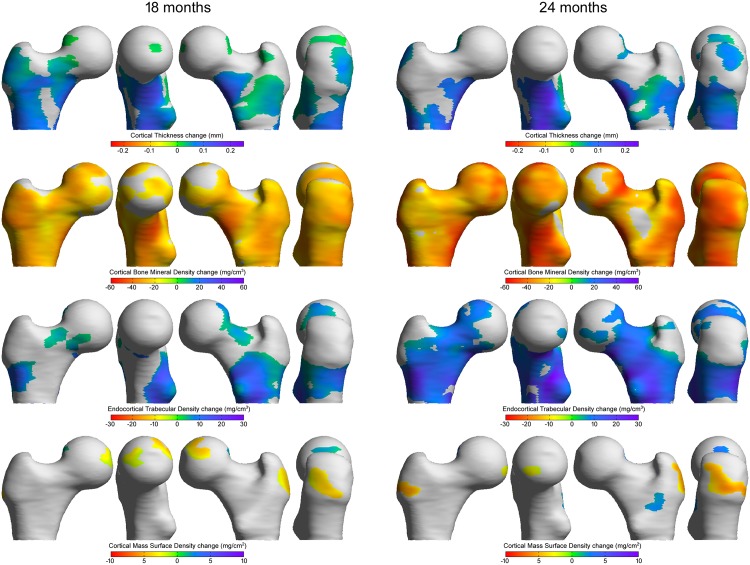
Cortical change maps (versus baseline) of the combined 18 month TPTD treatment cohort (left) and 24 month TPTD treatment cohort (right).The colours express the mean changes in the cortical parameter values. The grey regions indicate the changes to be not statistically significant (p>0.05) based on F-tests.